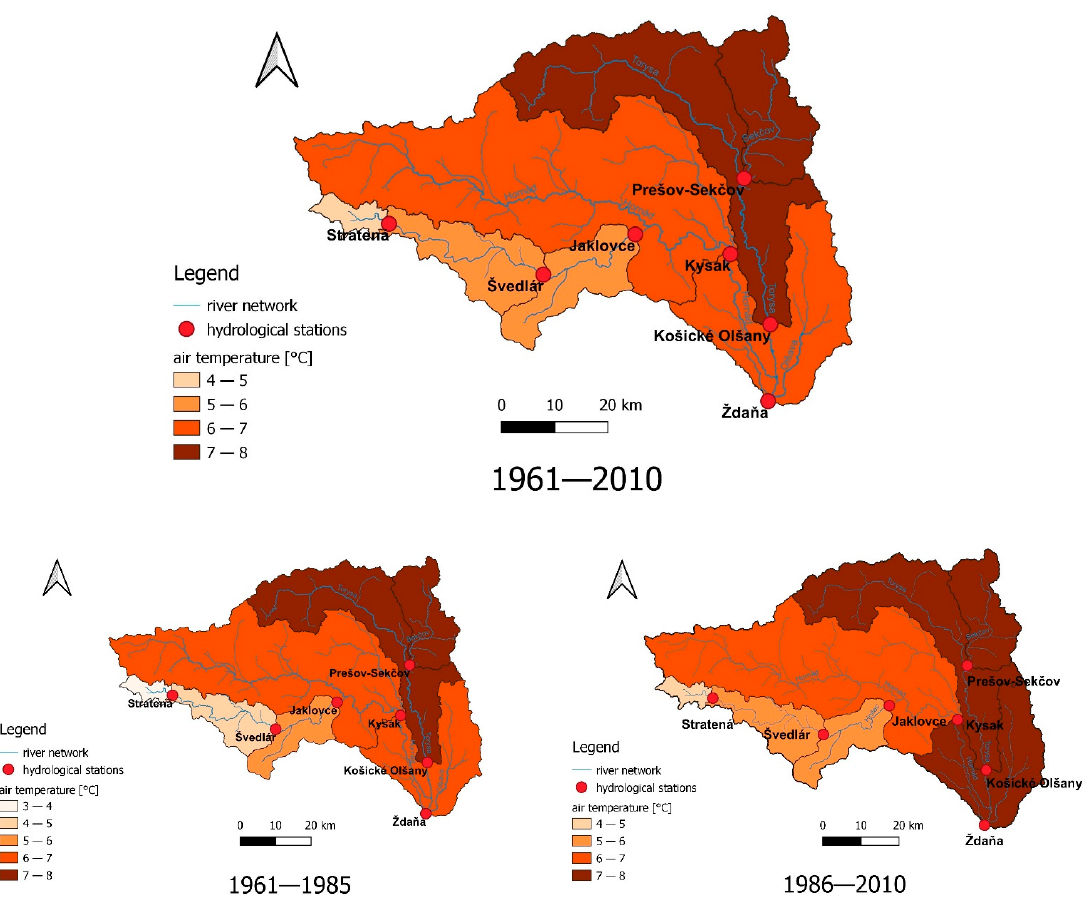
Figure 3. Average annual air temperature in the years 1961–2010, 1961–1986 and 1986–2010.